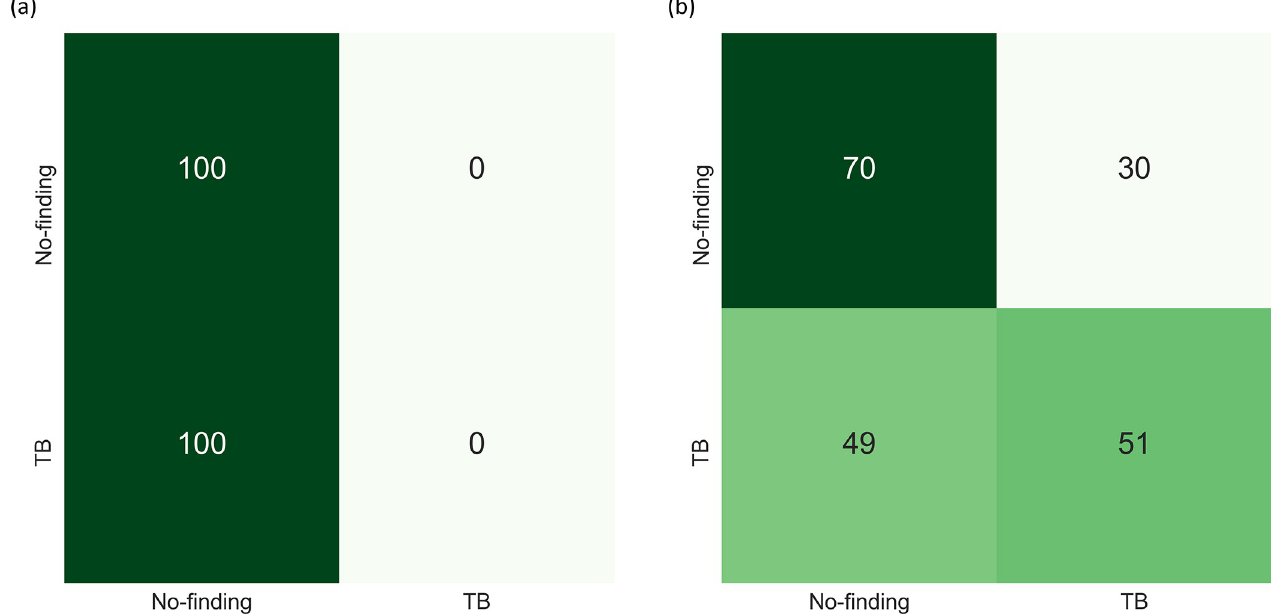
Fig 7. Confusion matrices obtained with the uncalibrated and calibrated probabilities (from left to right) at the baseline threshold of 0.5 for the Set-20 dataset constructed from the Shenzhen TB CXR dataset.